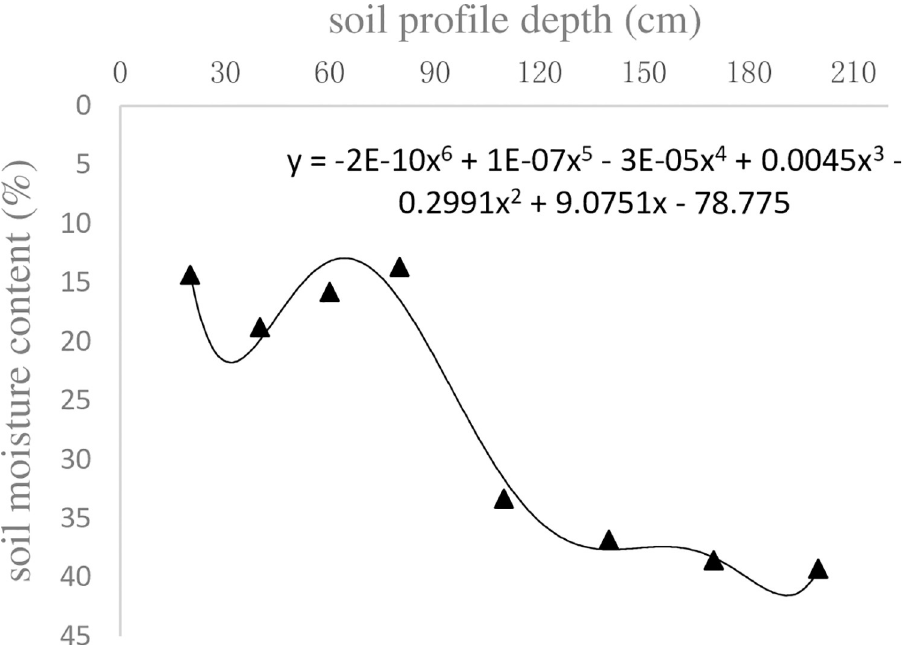
Fig 3. Relationship between initial moisture content and